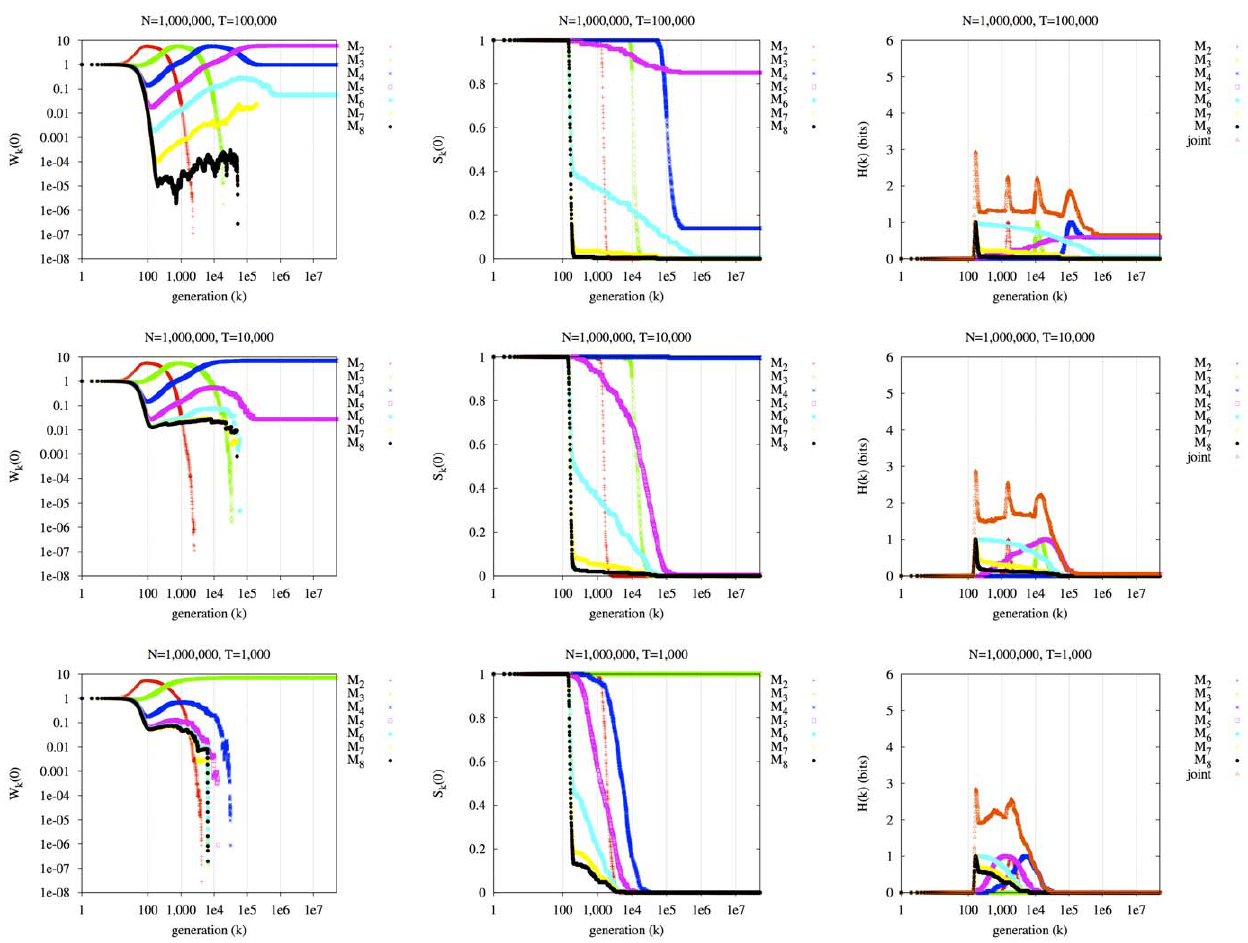
Figure 3. Effect of environmental switching on evolutionary dynamics of the seven mutator lineages. In rows: exponentially distributed environmental switching at three values of mean period T ( T =100,000, 10,000, 1,000). Left column: W k 0 ð Þ . Middle column: S k 0 ð Þ . Right column: H k ð Þ . N =1,000,000.